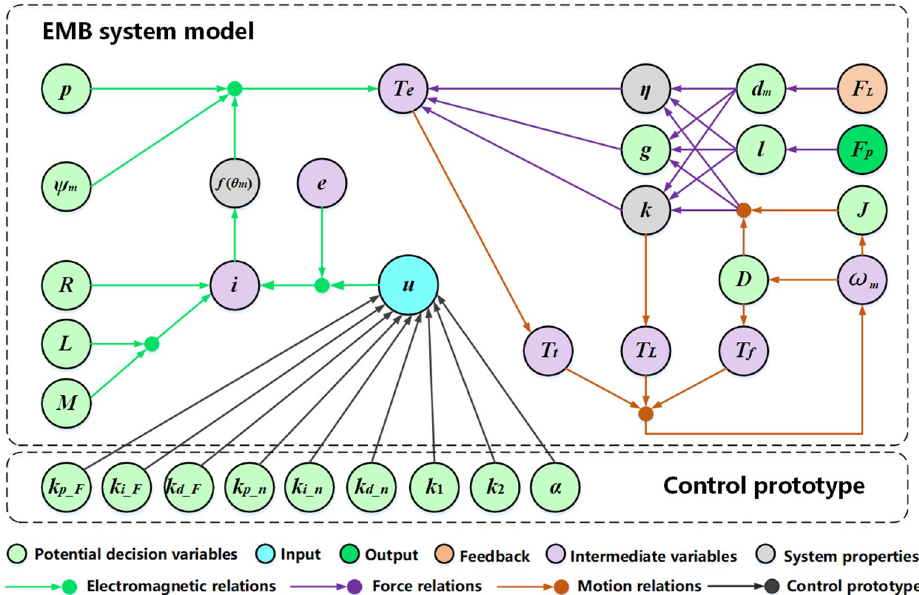
Fig 8. Parameters coupling relations. The coupling relations in Fig 8 include the electromagnetic relations, the force relations, the motion relations and the control prototype. Where, the green labeled parameters are the potential decision variables, the gray parameters are the EMB attributes, the purple parameters are the intermediate variables during calculation, and the rest are the input, the output and the feedback of the